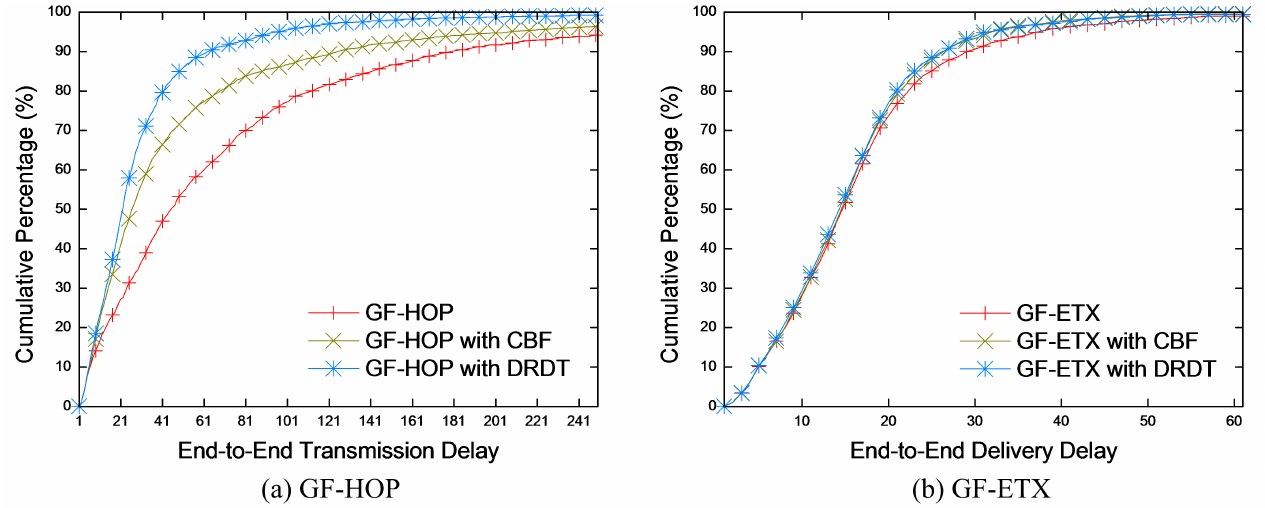
Figure 8. End-to-end transmission delay.